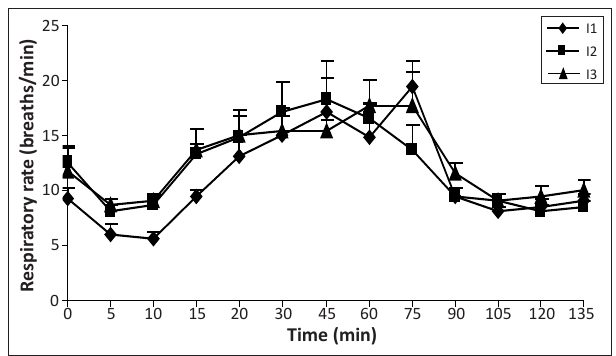
FIGURE 7: Mean ± standard error of respiratory rate (breaths/min) in water buffaloes of different